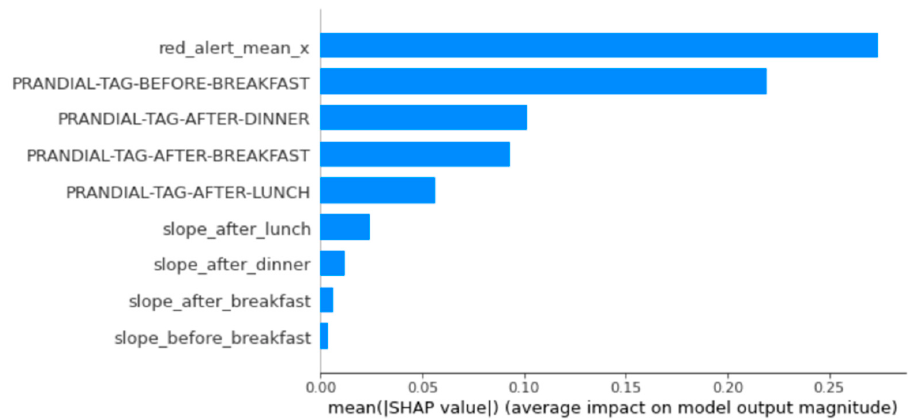
Figure A4. SHAP feature importance ranking for model trained on Tags, Gradients, and High-Read- ings.